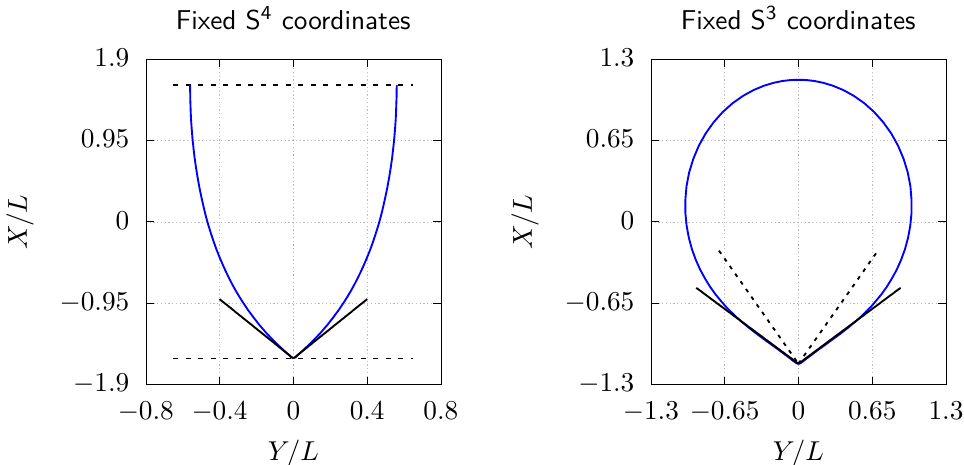
Figure 17. Embedding diagrams of ‘ = 1 lumpy black hole (blue line) in AdS 5 × S 5 , for the largest lumpiness parameter we have reached with fixed S 4 coordinates (left) and fixed S 3 coordinates (right). The black lines correspond to the cone embeddings proposed to mediate the topology change transition. For fixed S 3 coordinates, the embedding dictated by the Ricci-flat cone is indicated with dashed